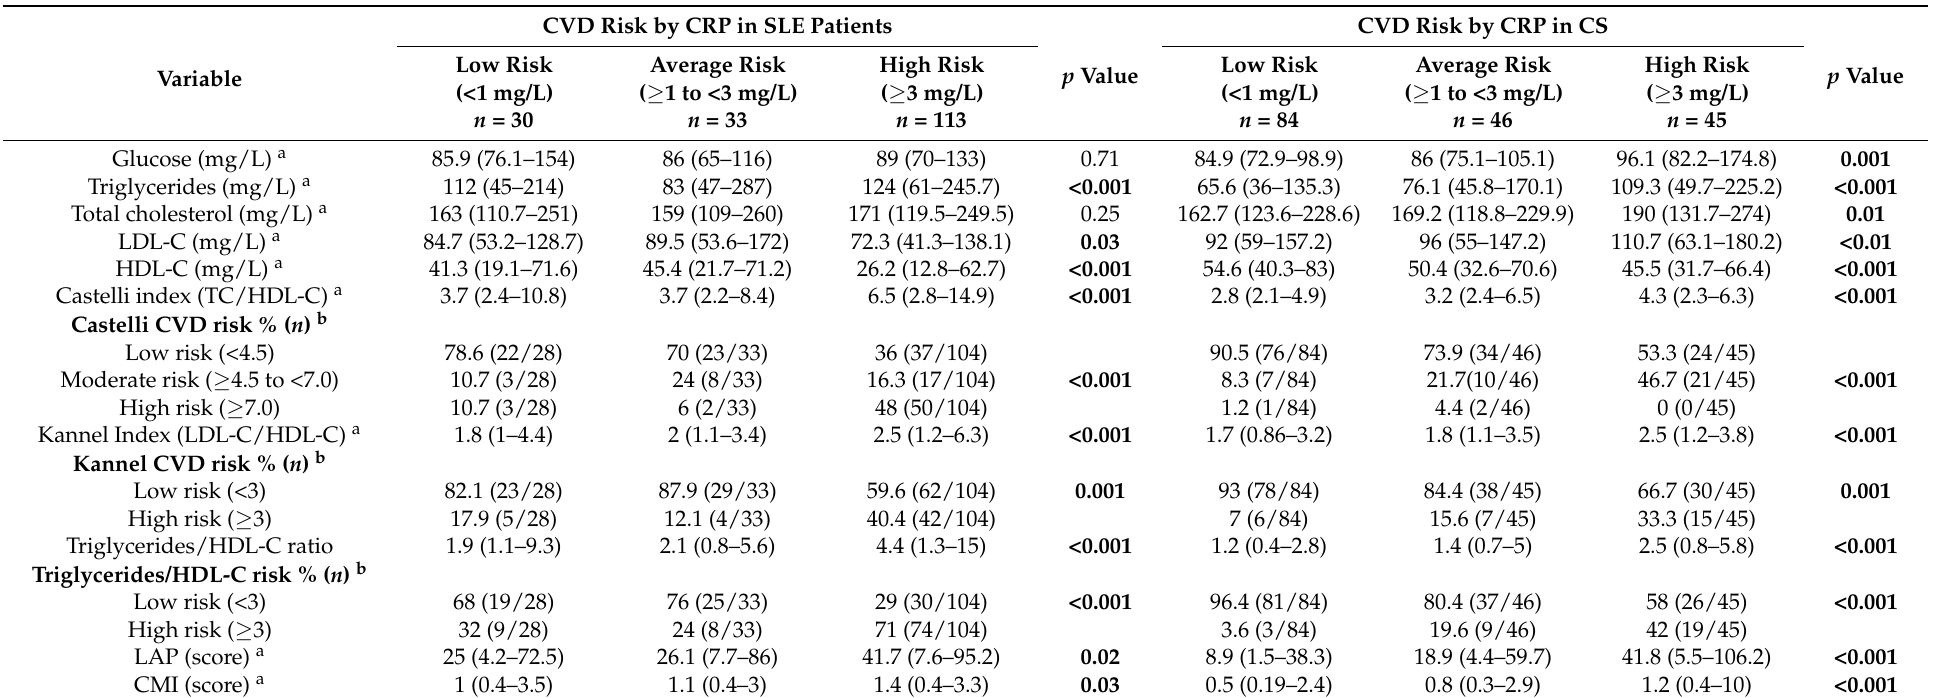
Table 2. Biochemical and cardiometabolic status stratified according to CVD risk by CRP in SLE patients and